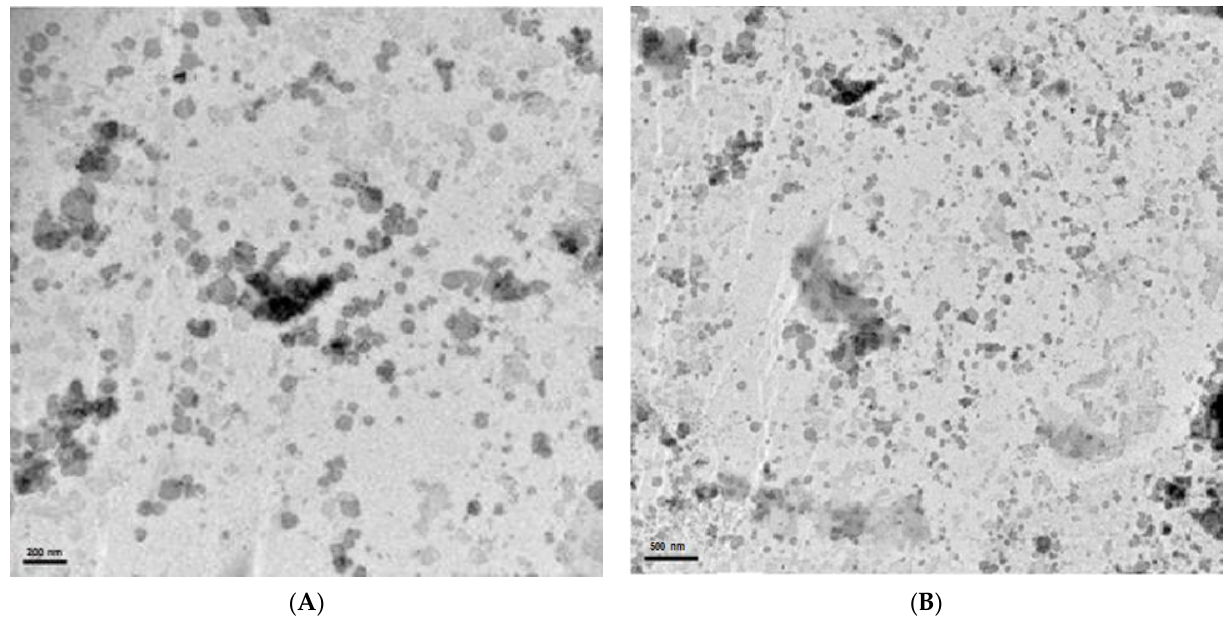
Figure 6. TEM micrographs of the optimized nanostructured lipid carrier containing Palmarosa essential oil OF12 at 80 kV. ( A ) 30 K magnification (scale bar = 200 nm), ( B ) 15 K magnification (scale bar = 500nm).